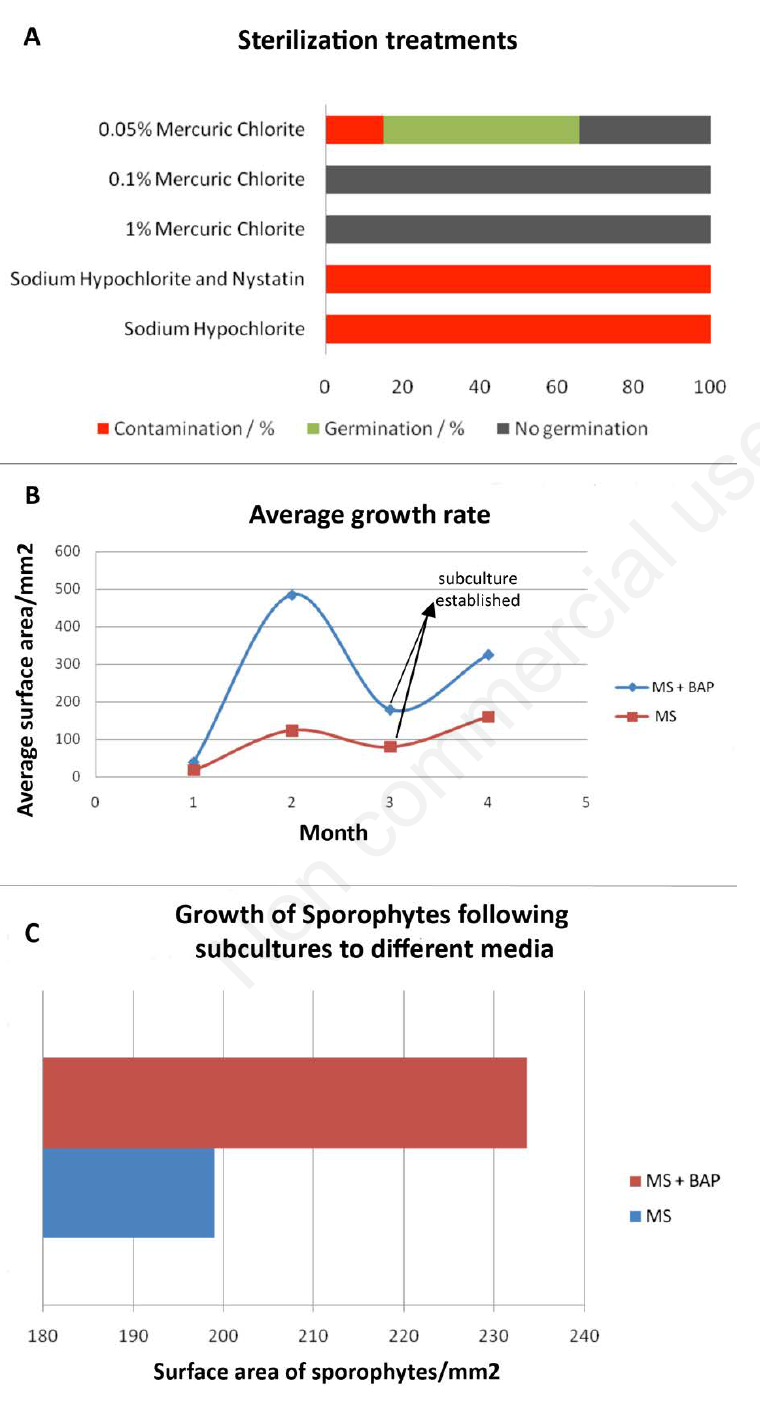
Figure 3. Efficiency of sterilization treatments (A), average growth rate from spores inoc- ulated (B) and difference in growth of sporophytes after subculturing